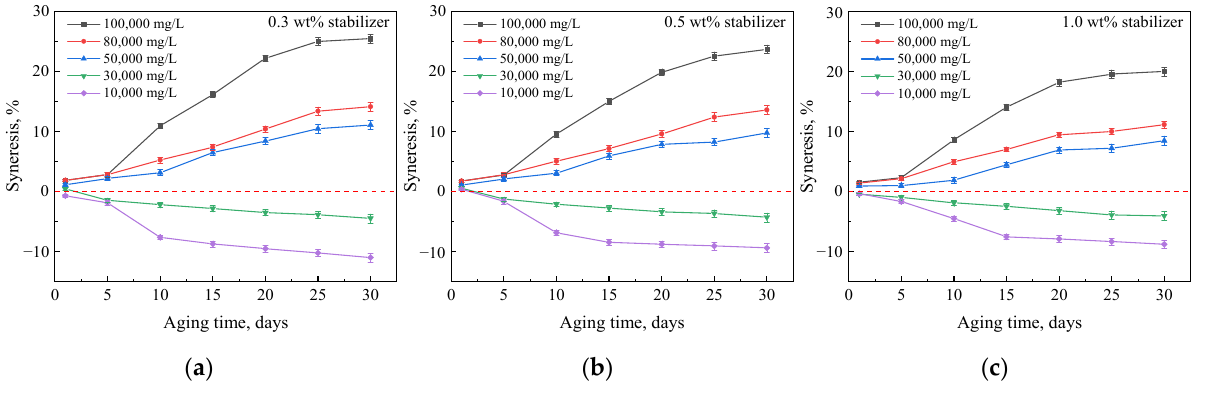
Figure 11. Mass changes of gels prepared with 0.5 wt% AM-AMPS25, 0.5 wt% crosslinker, and different concentrations of stabilizer after aging in brines with different salinities: ( a ) 0.3 wt% stabilizer; ( b ) 0.5 wt% stabilizer; ( c ) 1.0 wt% stabilizer.